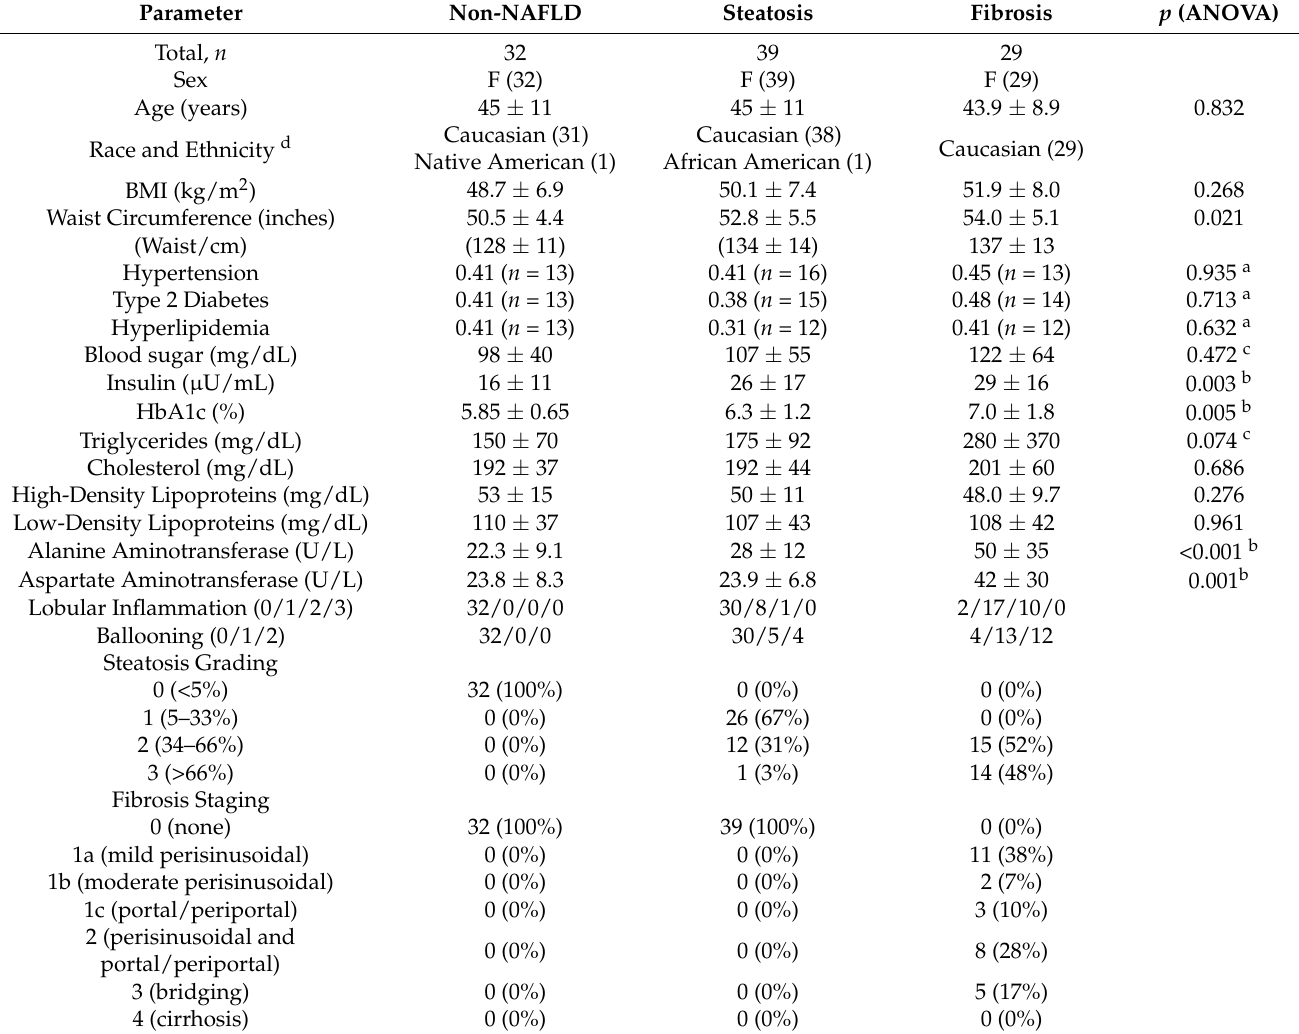
Table 1. Means and standard deviations, or frequencies and proportion percentages, for the characteristics of the three groups studied in this work are shown. Two significant digits are retained in the standard deviation (SD), and the means rounded to the decimal place dictated by the